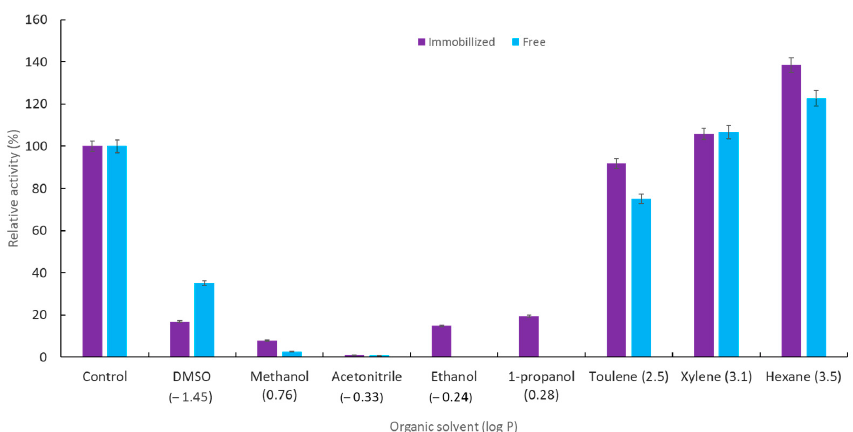
Figure 9. Effect of different solvents on immobilized YT PTE and free enzyme activity. Purple columns: Relative activity of immobilized YT PTE; Blue columns: Relative activity of free enzyme. Log P is the logarithm of the 1-octanol/water partition coefficient.